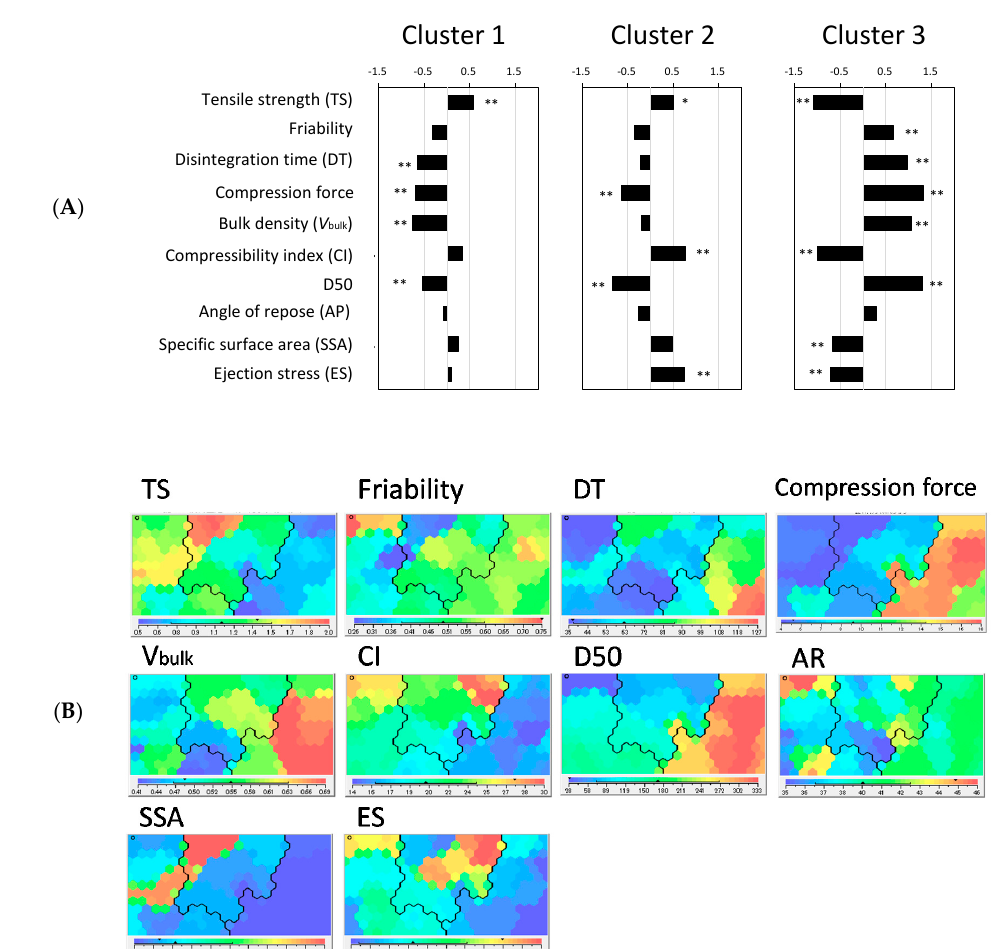
Figure 5. Powder and tablet characteristics of the SOM clusters. ( A ) Profiling analysis of SOM clusters. Each value represents the standardized di ff erences in the means of variables between each cluster and the entire data set calculated according to Equation (3). The TS data were acquired from the model